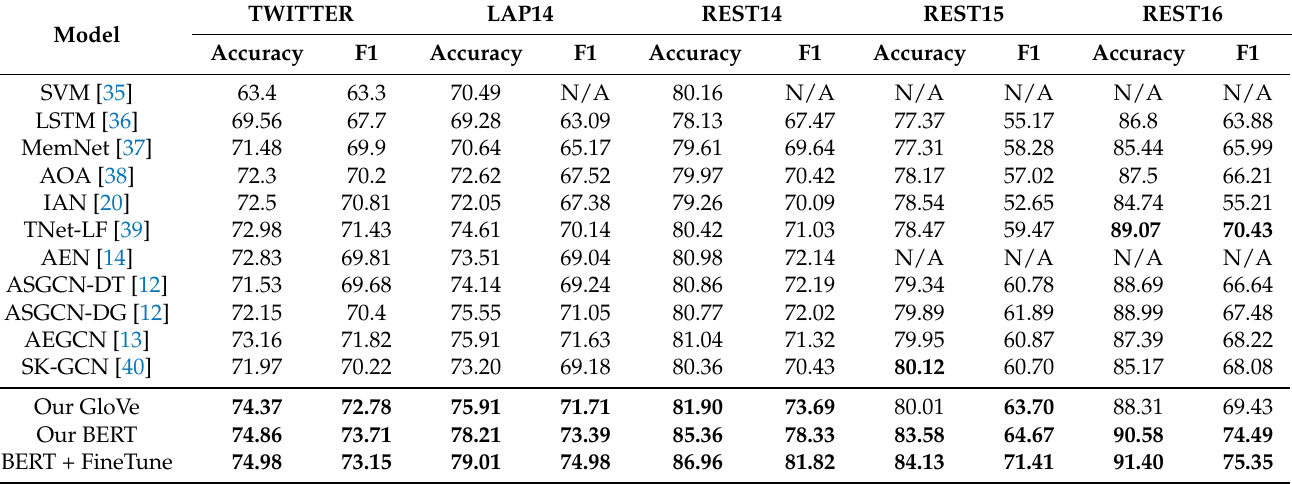
Table 2. Model comparison results (%). The top two results with each dataset are in bold. We use “N/A” to represent unreported experimental results. The comparison models’ results were retrieved from the original papers.